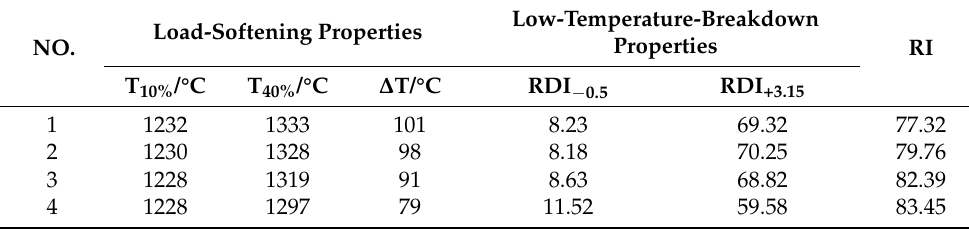
Table 6. Load-softening properties of sinter with different charcoal